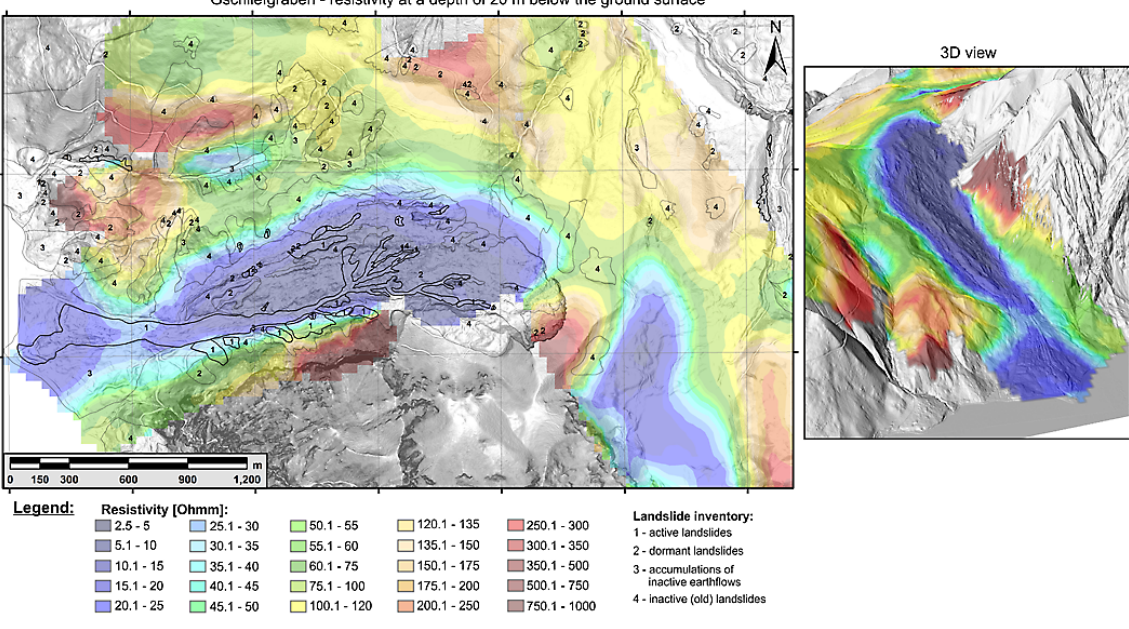
Fig. 7. Map of the subsurface resistivity derived from AEM data (depth slice) at a depth of 20m below the ground surface compared to the landslide inventory map; right side: 3-D view from the